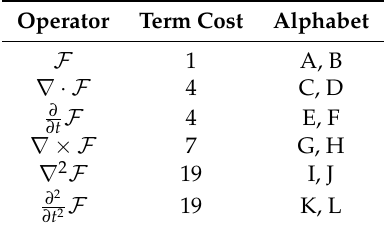
Table 1. Complexity of each operator term working on a field F ∈ { E , B }